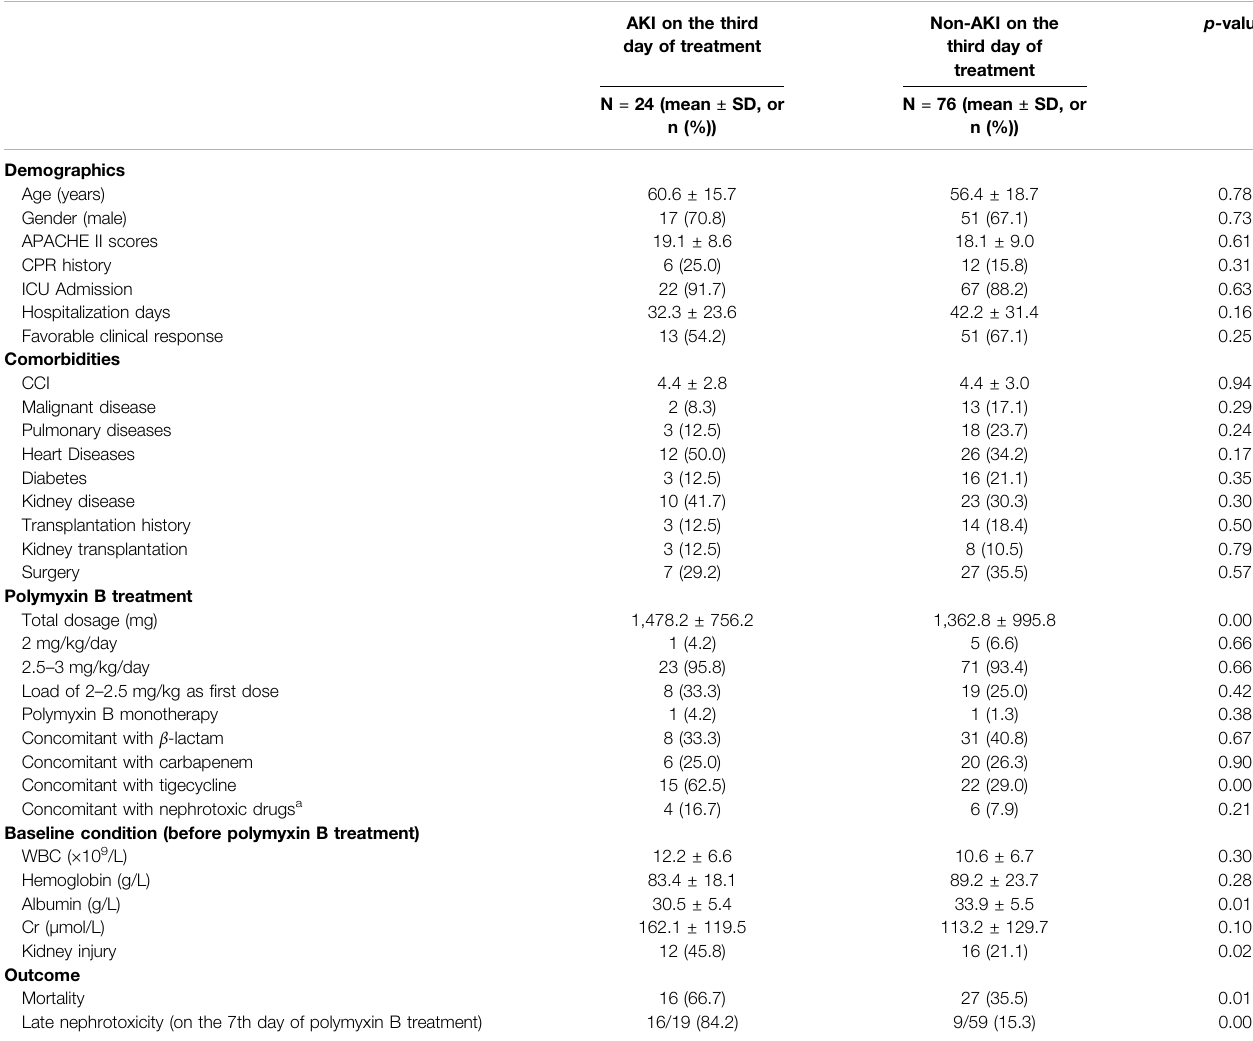
TABLE 2 | Univariate analysis for early nephrotoxicity.